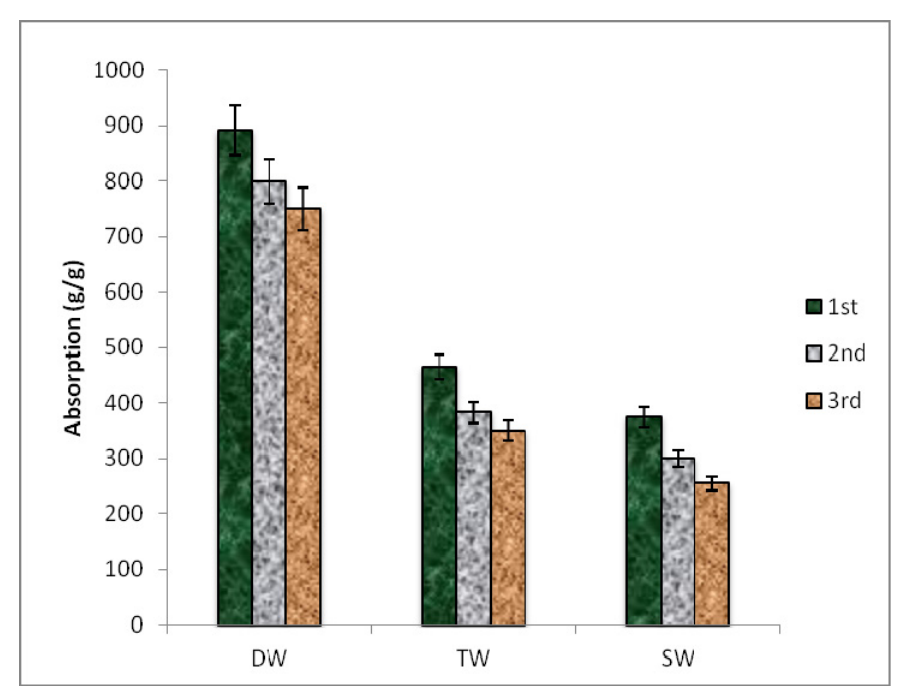
Figure 5. Absorption of distilled water (DW), tap water (TW) and saline water (SW) by SHNC during 1st, 2nd and 3rd wetting and drying